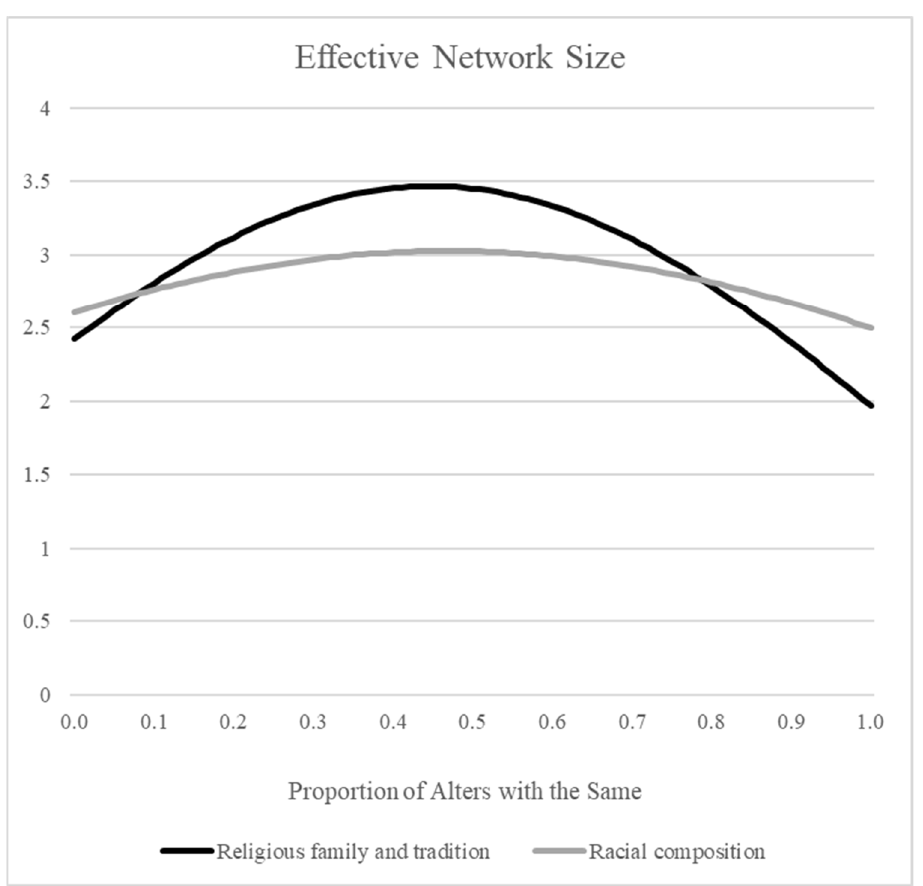
Figure 2. Predicted effective network size by homophily.